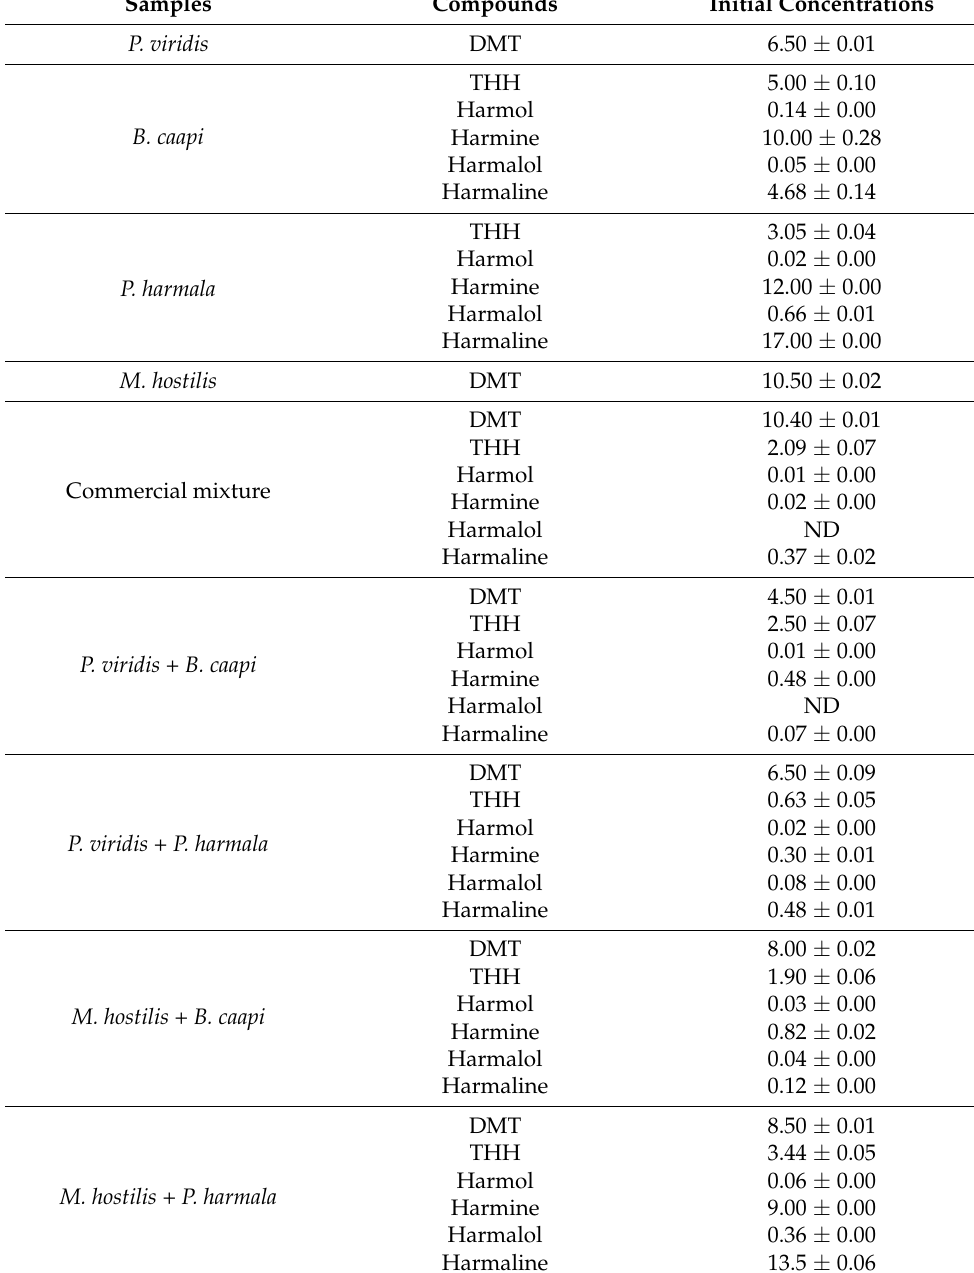
Table 1. Concentration of the main compounds of ayahuasca in different vegetal samples. The values are expressed as mean ( µ g/mg extract) ±